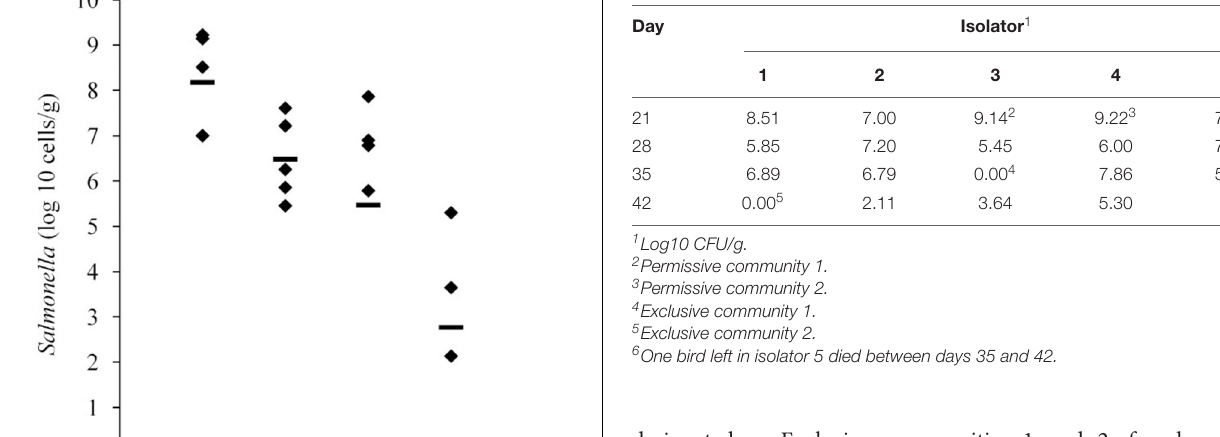
to identify OTUs associated with carriage status ( p < 0.05).